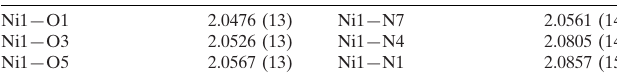
Selected bond lengths (A˚ ).